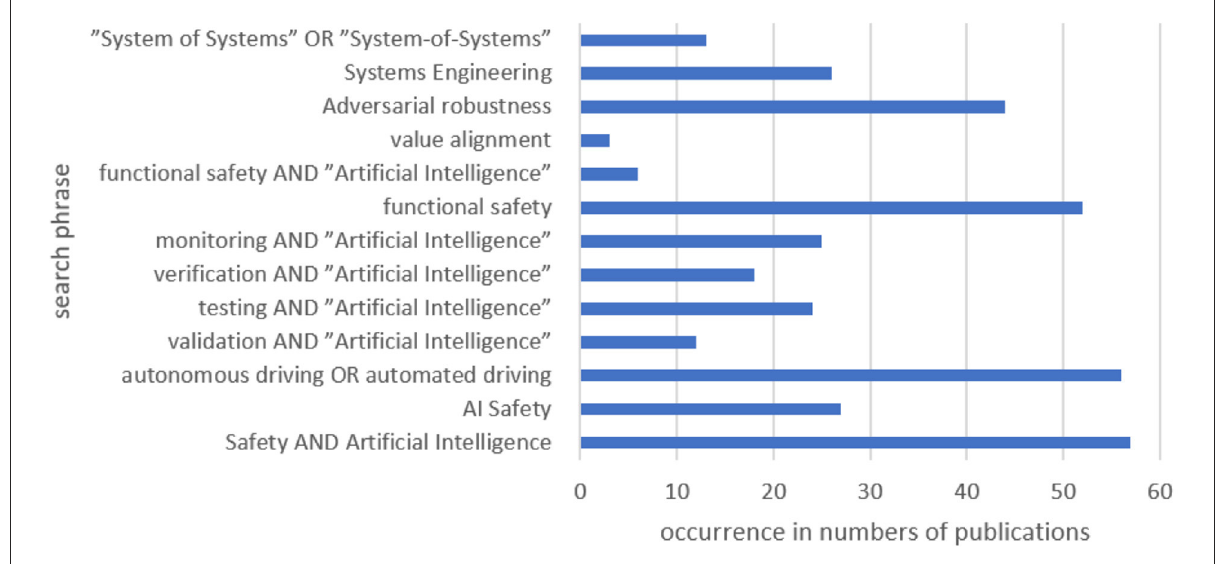
FIGURE6 Occurrences of search phrases in